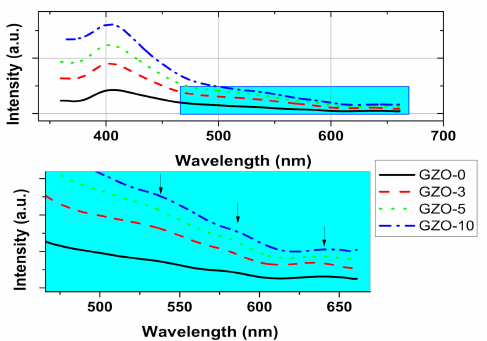
Figure 6. PL spectra of as-synthesized Ga doped ZnO (GZO-0, GZO-3, GZO-5, and GZO-10) samples @ excitation wavelength of 350